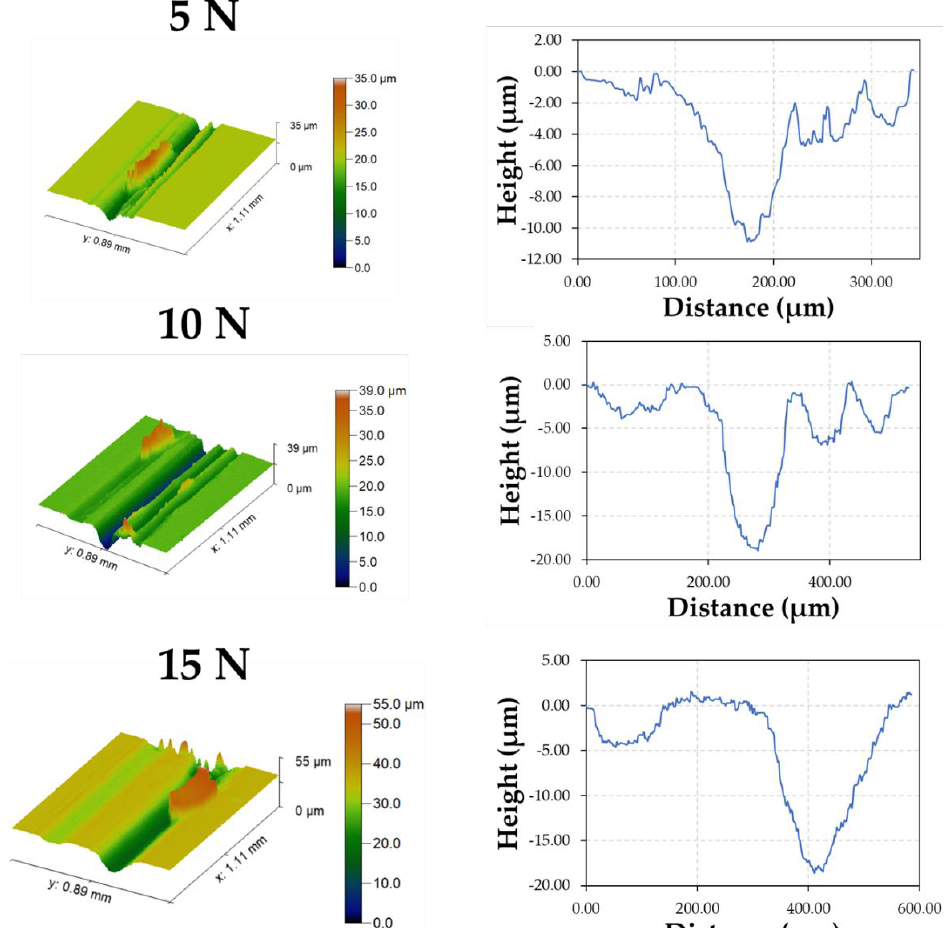
Figure 17. The wear tracks of the Zr-coated specimen S5 under the normal loads of 5, 10, and 15